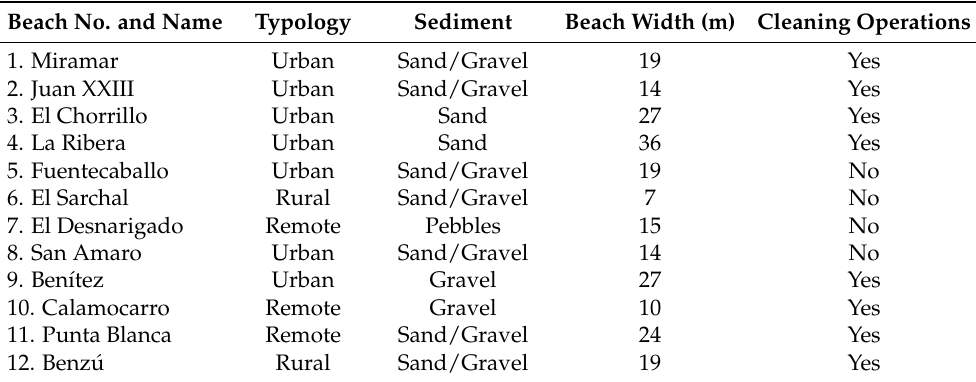
Table 1. Principal characteristics of studied beaches.